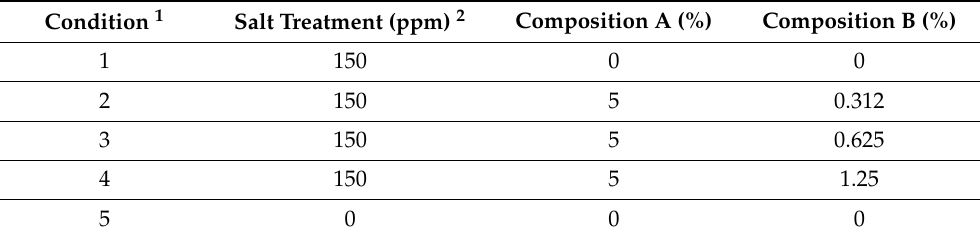
Table 3. Conditions of different plants’ treatment under salt stress: the case of spring wheat [9]. Condition